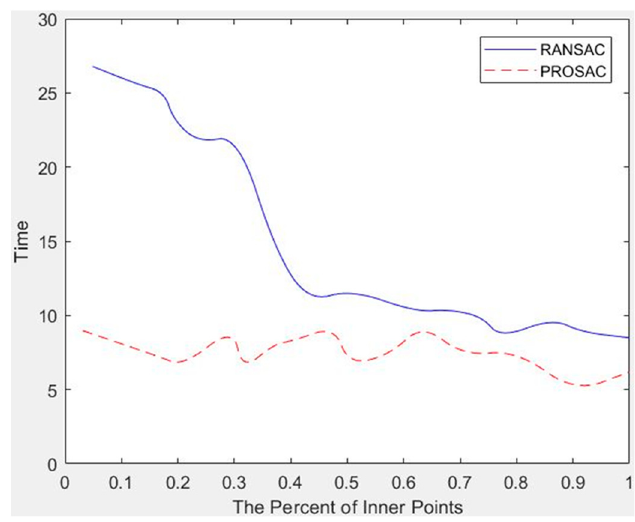
Figure 14. Time-proportion of interior points: comparison between RANSAC and PROSAC.